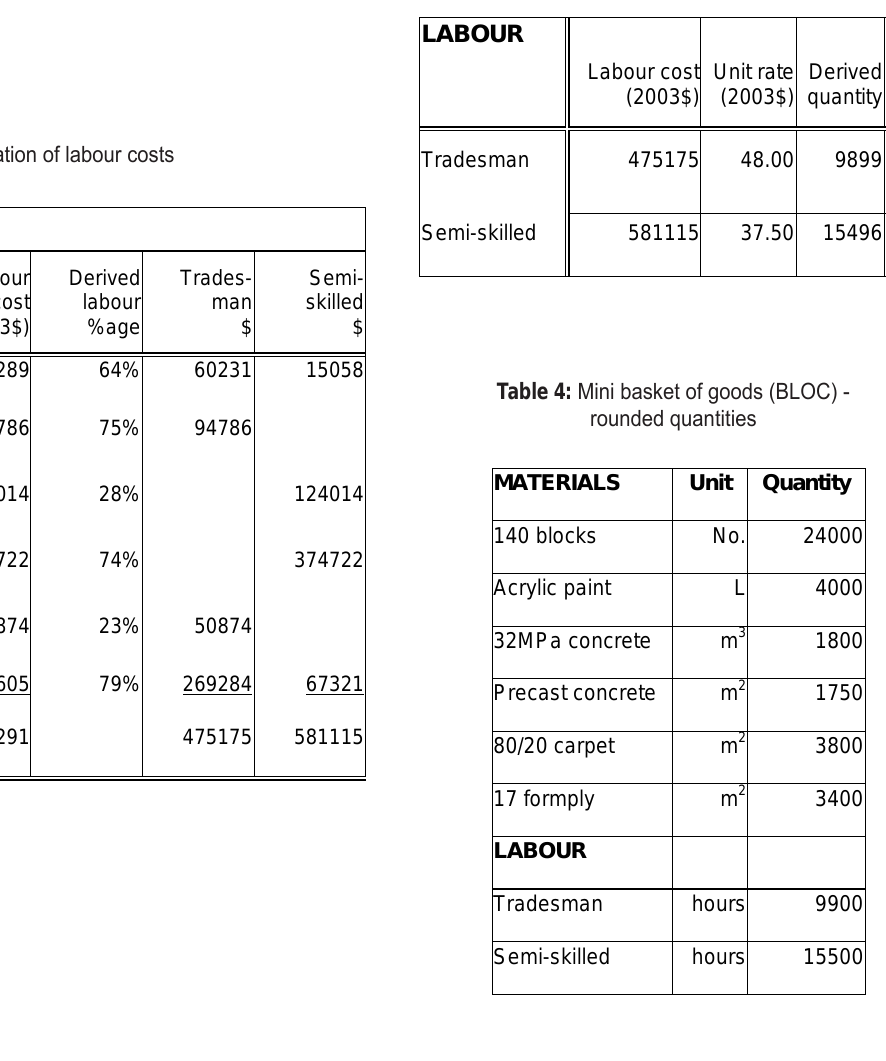
Table 3: Calculation of labour quantities